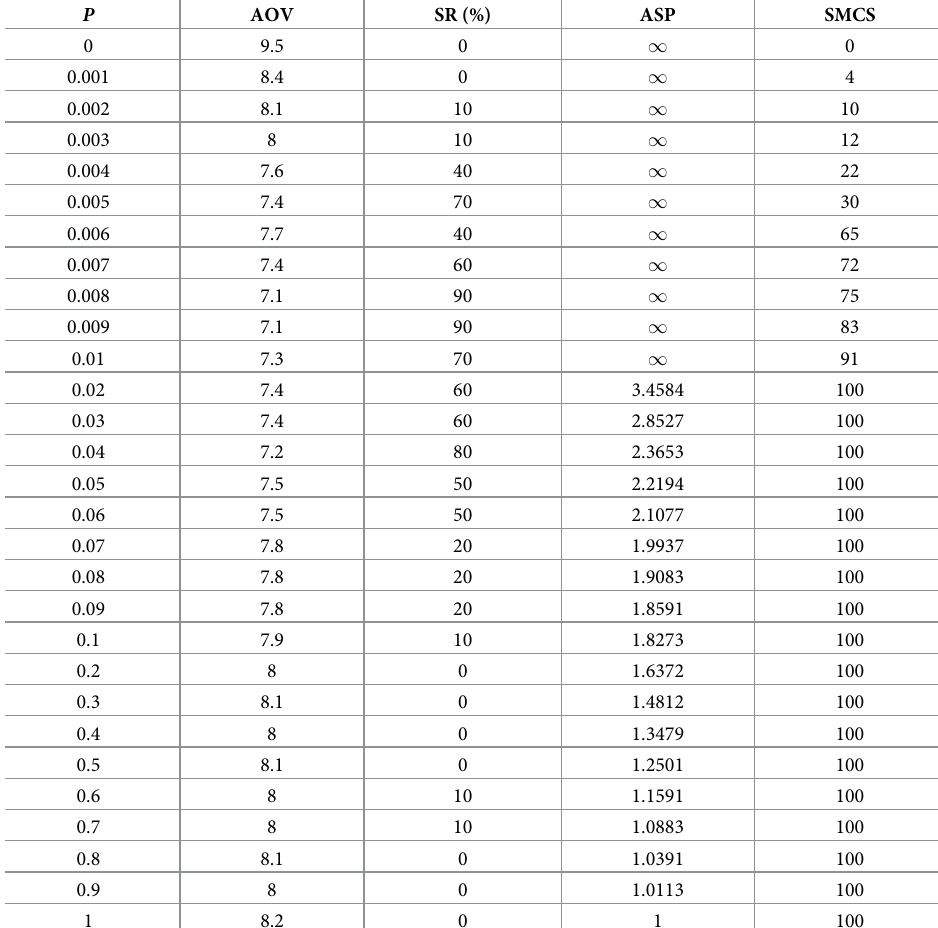
Table 4. Values of AOV, SR, ASP, and SMCS for different values of P